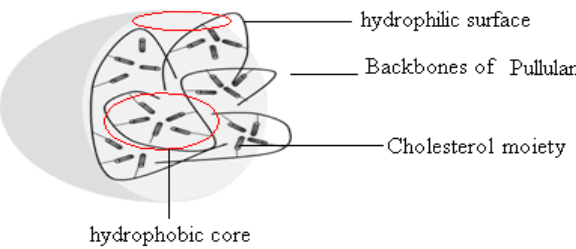
Figure 2. Structural graph of pullulan nanoparticle.